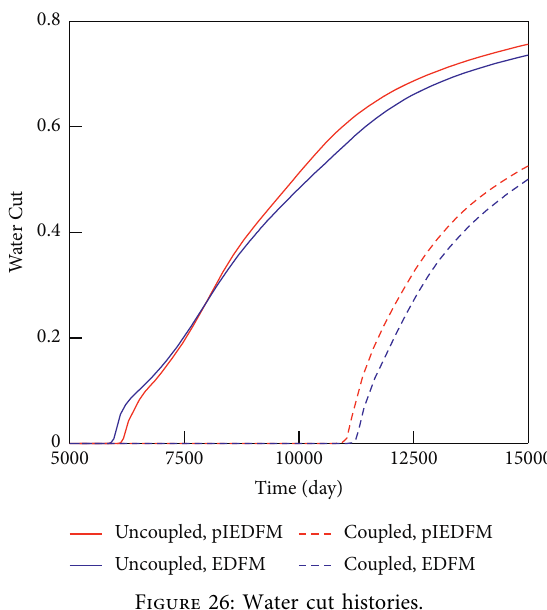
Figure 26: Water cut histories.